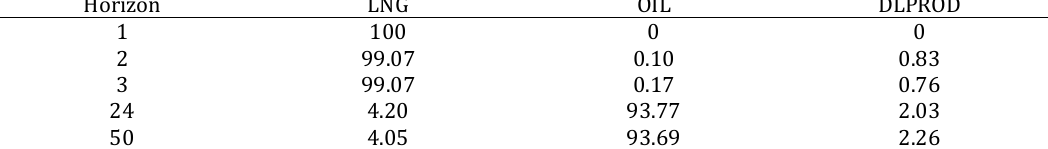
Table 4: Percent contribution of shocks to the overall variability of the LNG prices